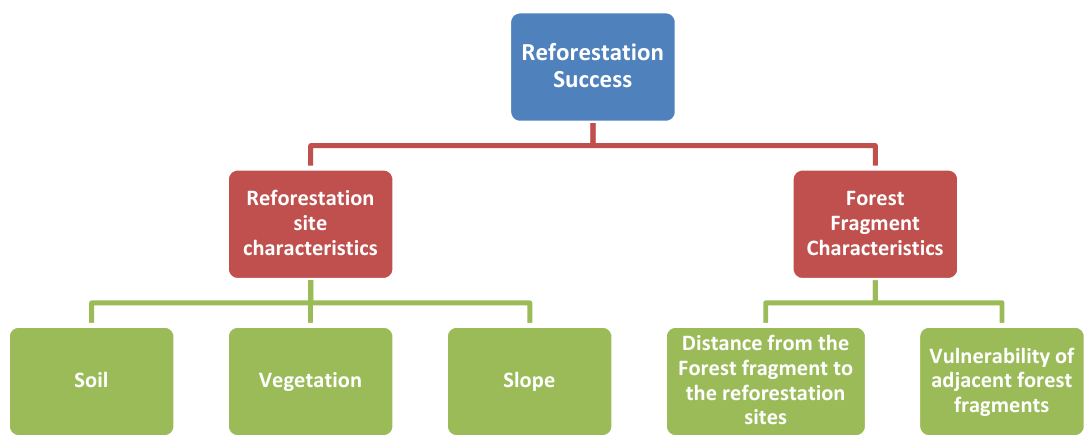
Figure 4. The hierarchical structure of the criteria.